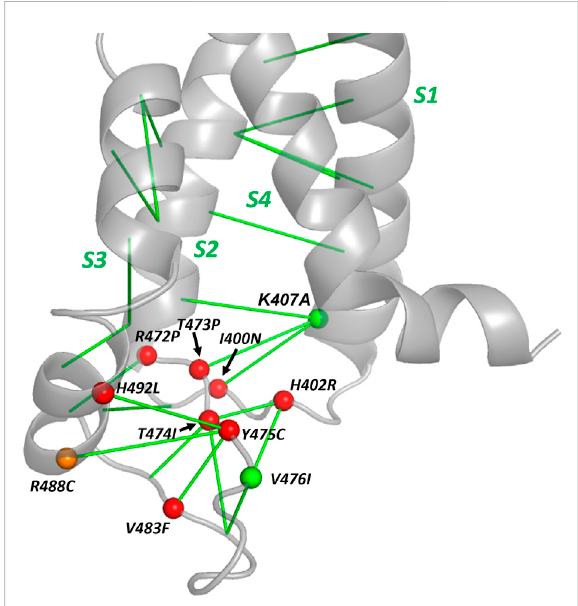
FIGURE 8 Afolding-sensitiveregionaroundthecytoplasmicS2-S3loop of the hERG voltage sensor domain. The backbone structure on the cytoplasmic side of the VSD is shown with the location of tested variants identi fi ed with a sphere on the C α atom. Red and orange spheres are variants with severe or moderate reductions in cell surface expression, respectively and green spheres indicate variants with WT traf fi cking (Table 4). EC interactions are represented with green lines connecting C α atoms. The structural contexts of residues K407 and R488 are illustrated in Supplementary Figure